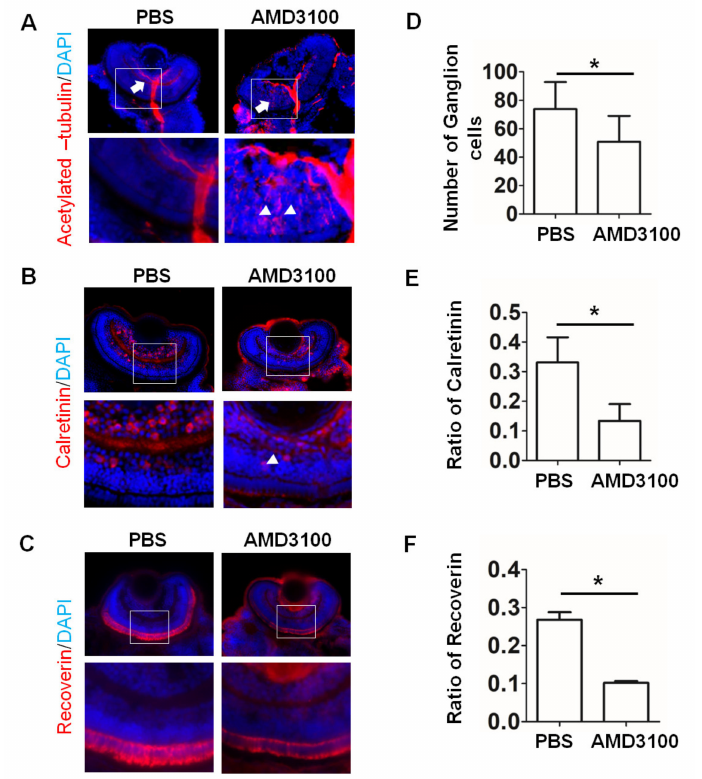
Figure 11. AMD3100 treatment in zebrafish leads to morphological changes in the retina similar to those detected in retinal organoids. ( A ) Ganglion cells were stained for acetylated tubulin in the PBS and AMD3100 treatment groups at 72 hpf, and ganglion cells were mislocalized in the AMD3100 treatment group (white arrow). ( B ) Amacrine cells were stained for calretinin in the PBS and AMD3100 treatment groups at 72 hpf, and amacrine cells were mislocalized in the AMD3100 treatment group (white arrow). ( C ) Photoreceptor cells were stained for Recoverin in the PBS and AMD3100 treatment groups at 72 hpf. ( D ) The relative ratio of acetylated tubulin-positive cells to all cells (nuclei were stained with DAPI) significantly decreased in the AMD3100 group (* p < 0.05, n = 12). ( E ) The relative ratio of calretinin-positive cells to all cells (nuclei were stained with DAPI) significantly decreased in the AMD3100 group (* p < 0.05, n = 12). ( F ) The relative ratio of the Recoverin-positive cells to all cells (nuclei were stained with DAPI) significantly decreased in